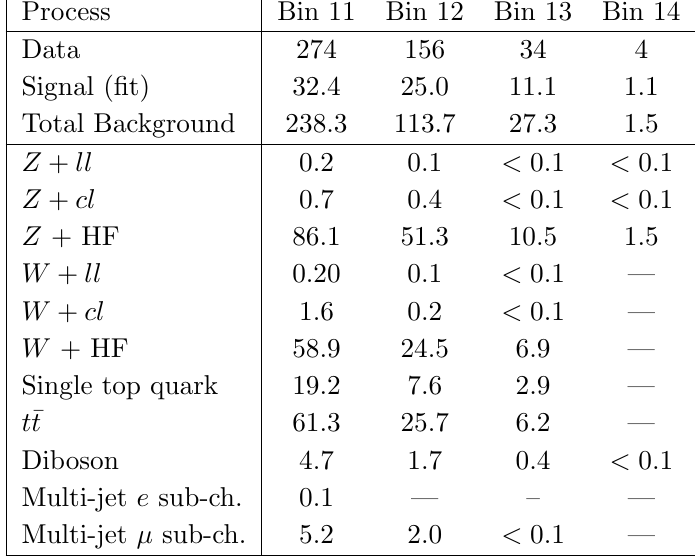
Table 15 . The numbers of (cid:12)tted signal and background events and the observed numbers of events in the four highest S=B bins of (cid:12)gure 6. An entry of \{" indicates that a speci(cid:12)c background component is negligible in a certain bin, or that no simulated events are left after the analysis